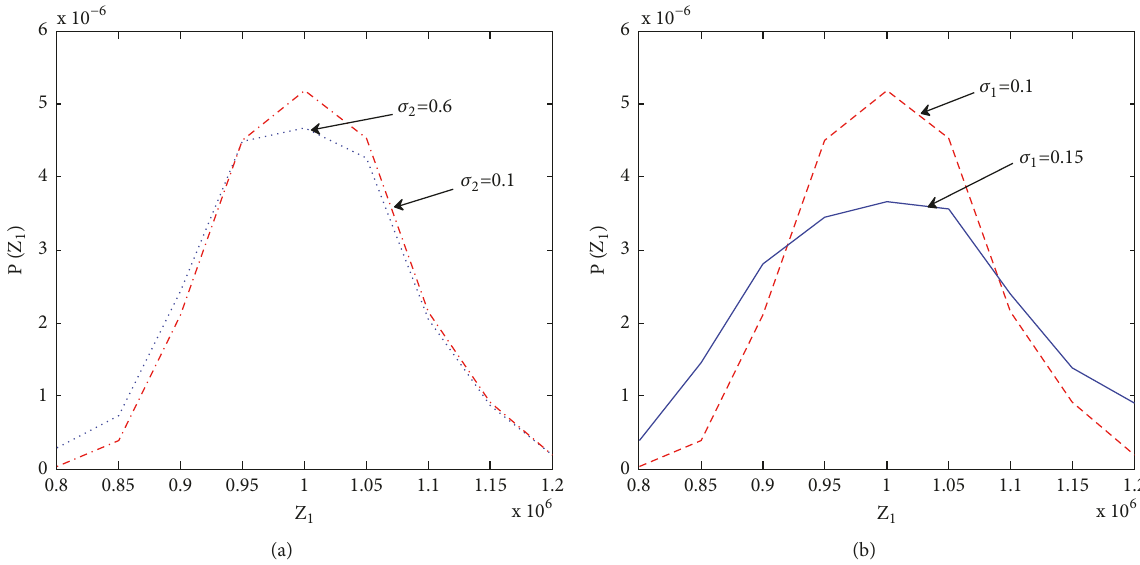
Figure 4: The stationary marginal probability density of uninfected target cells 𝑍 1 (𝑡) . (a) 𝜎 1 = 0.1 is fixed with 𝜎 2 = 0.1 and 𝜎 2 = 0.6 . (b) 𝜎 = 0.1 is fixed with 𝜎 = 0.1 and 𝜎 = 0.15 . 2 1 1